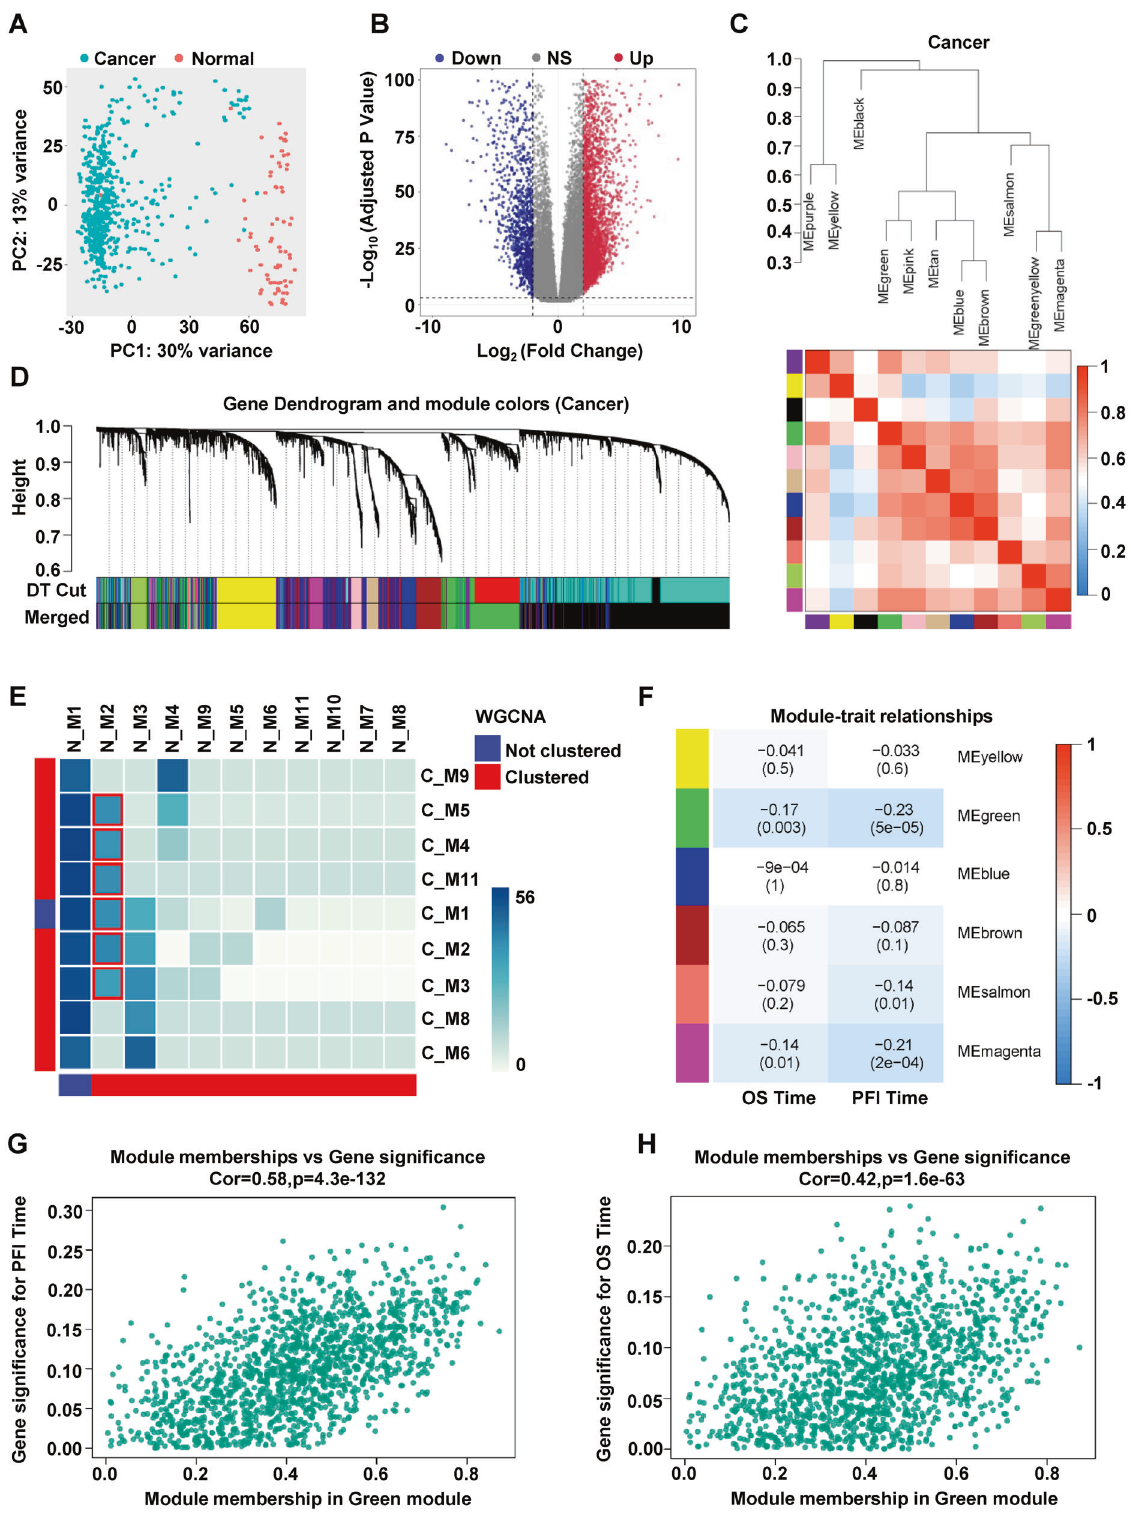
Fig. 1 Weighted gene co-expression network analysis. A Principal component analysis of RCCC cancer group and normal groups. B Volcano plot of differentially expressed genes between cancer and normal groups. C According to the combination of module dissimilarity, 11 sub modules were fi nally obtained in the cancer group. D The correlation between cancer network modules. E Cross analysis of cancer module and normal module, color block represents the number of overlapping genes. F Heat map showing correlation between the gene module and clinical traits. G The relevance of module membership in green and gene signi fi cance for PFI time. H The relevance of module membership in green and gene signi fi cance for OS time.